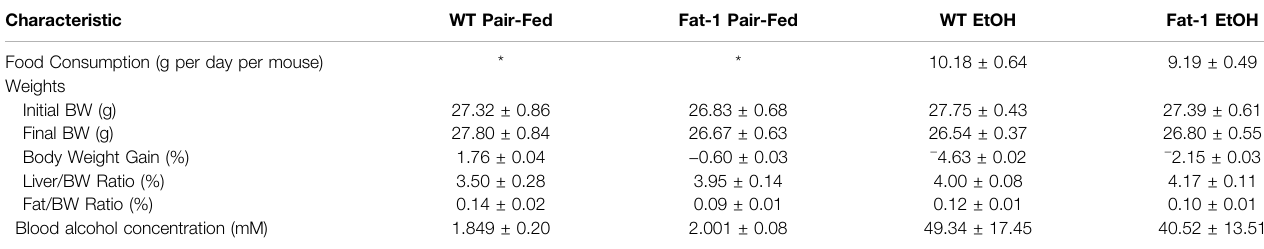
TABLE 2 | Metabolic characteristics of WT and fat-1 mice in an acute-on-chronic model of ALD.